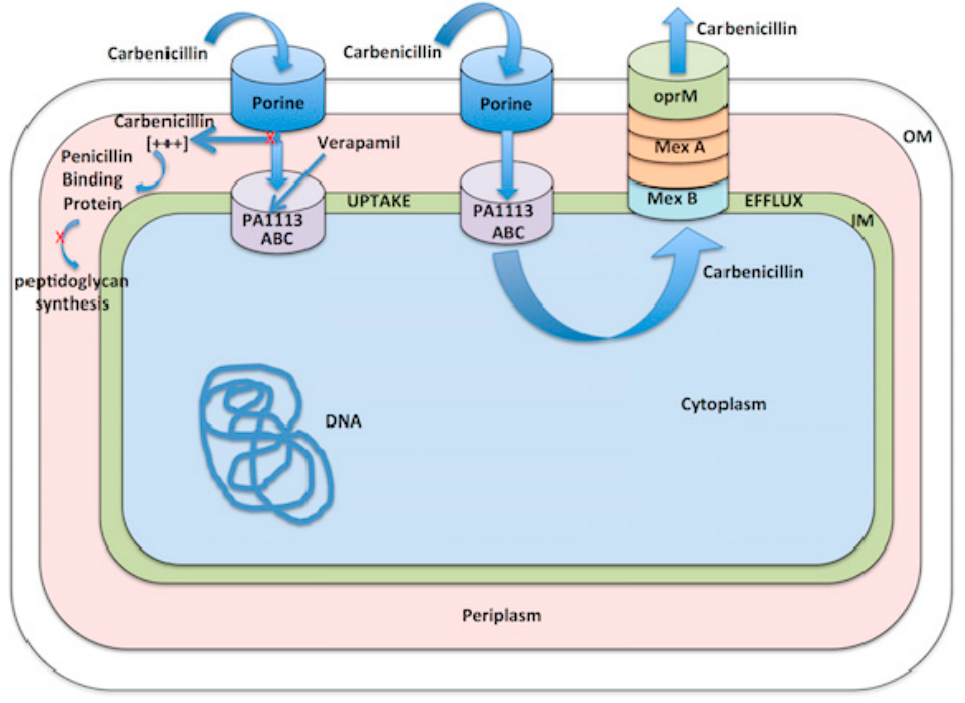
Figure 9. Proposed mechanism for carbenicillin influx.